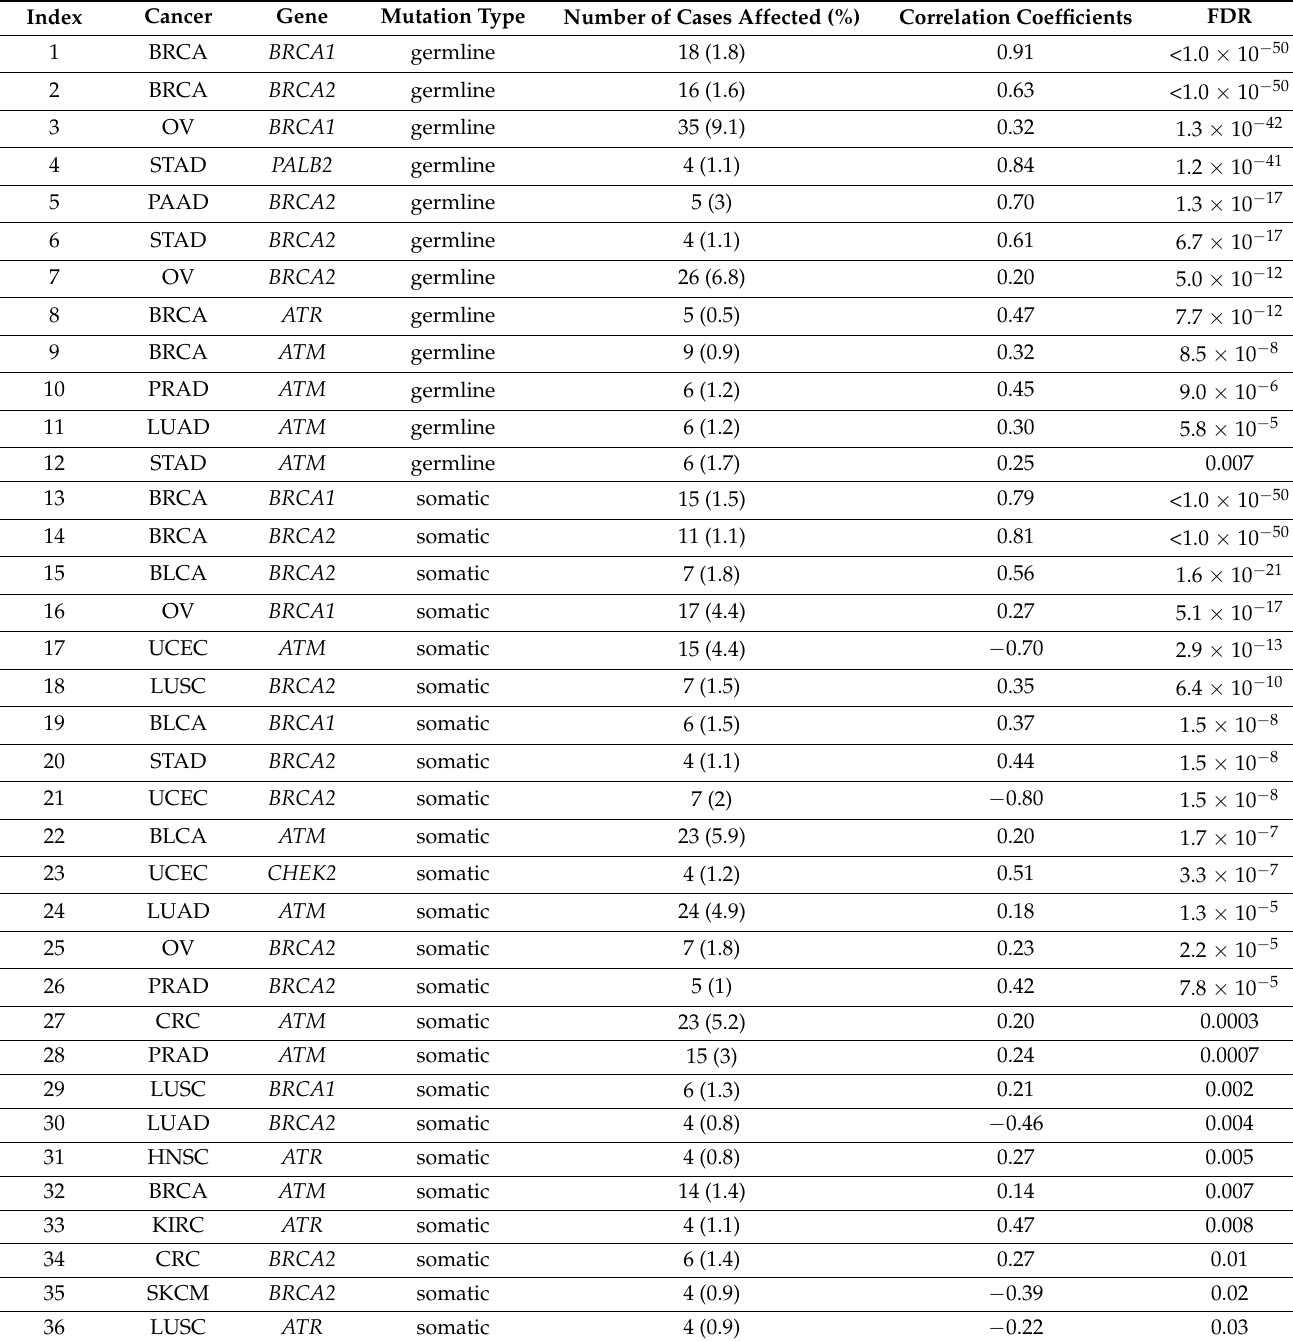
Table 1. The significant associations (FDR < 0.05) of germline variants and somatic mutations with HRD